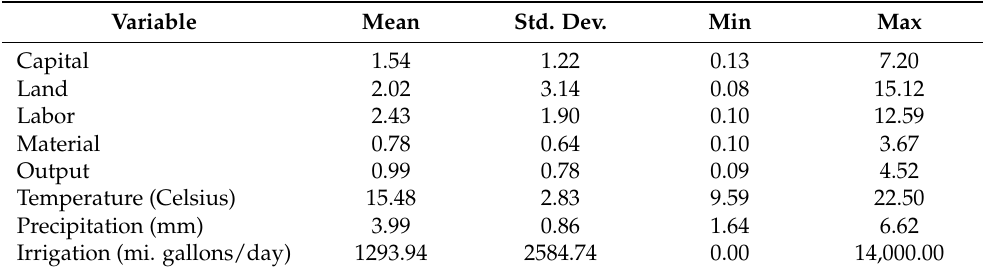
Table 1. Descriptive Statistics of Conventional Inputs and Environmental Variable used in the TFP